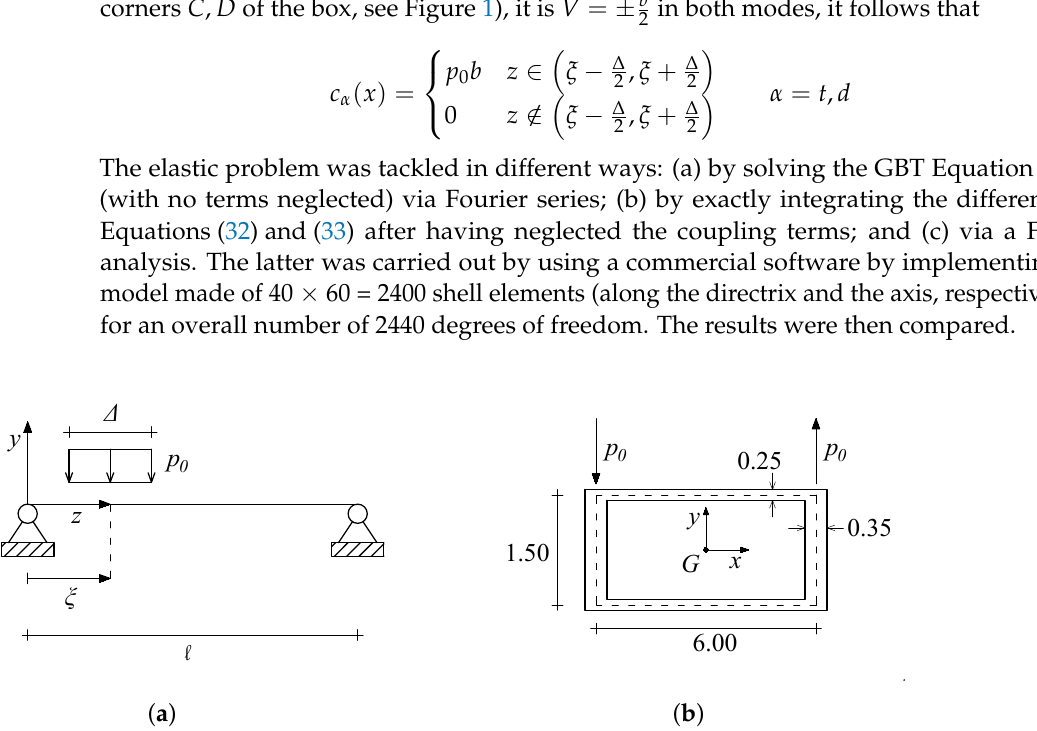
Figure 12. Segment of distributed load, p 0 = ± P ∆ , centered at z = ξ : ( a ) longitudinal view; ( b ) cross section at z = ξ , dimensions in